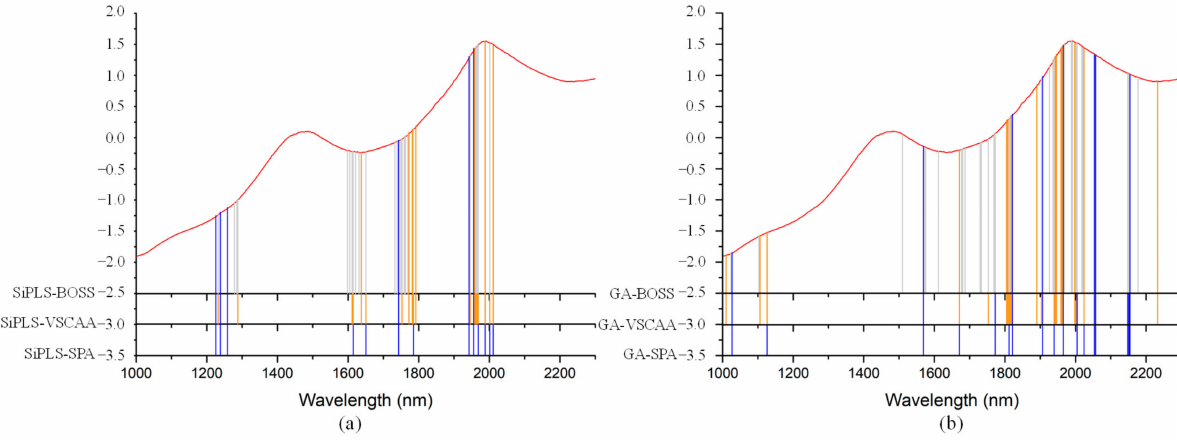
Figure 15. The useful variables selected by the ( a ) SiPLS-SPA, SiPLS-VSCAA, and SiPLS-BOSS and the ( b ) GA-SPA, GA-VSCAA, and GA-BOSS algorithms for measuring TI. Table 6. PLSR modeling results for TI based on variables selected by different